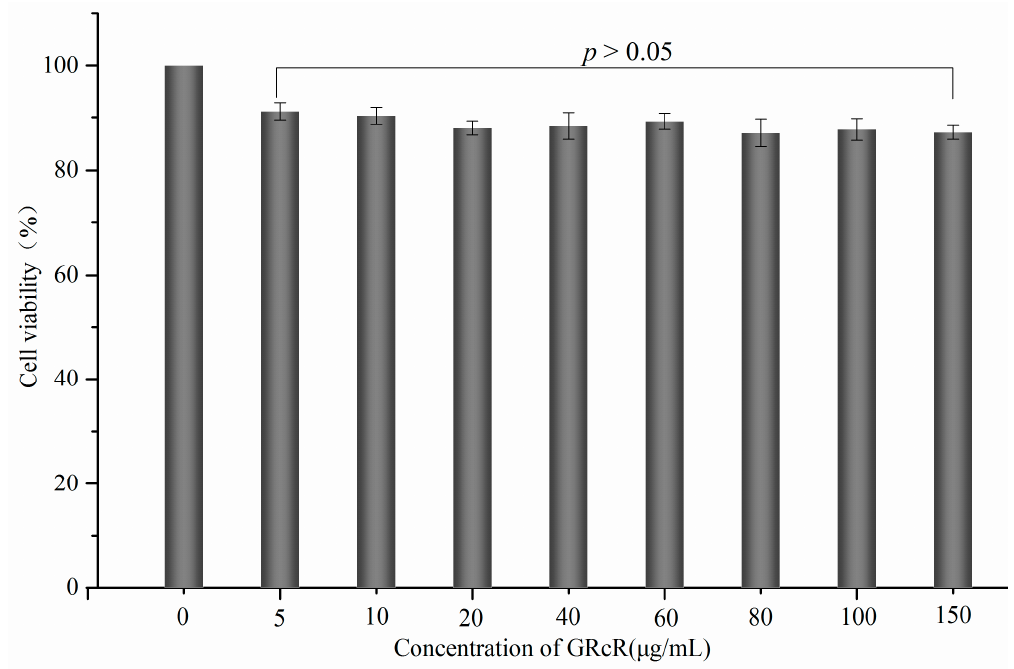
Figure 10. MTT assay for GRcR at different concentrations of HeLa cells, the data was presented as the mean ± SD, n =